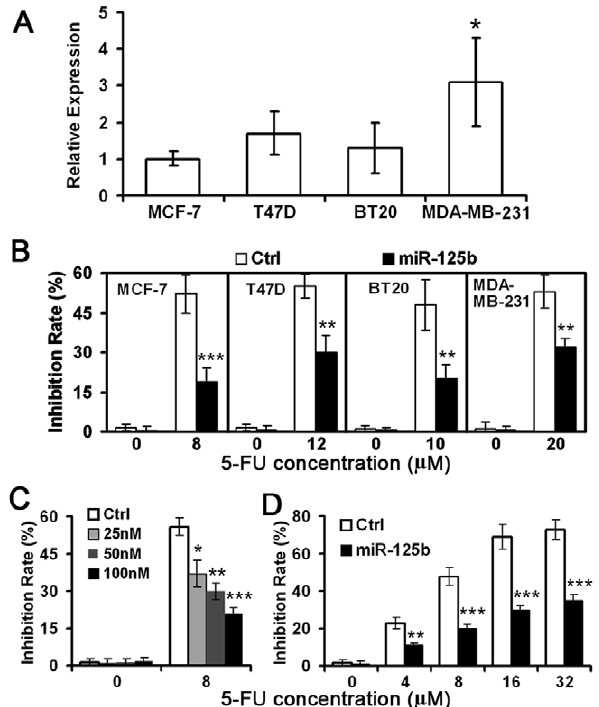
Figure 4. Involvement of miR-125b in chemotherapeutic resistance in breast cancer cells. (A) Relative expression levels of endogenous miR-125b were measured in breast cancer cell lines by quantitative RT-PCR. Data represented mean 6 SD. * p , 0.05 compared to MCF-7. (B) Breast cancer cells, MCF-7, T47D, BT20 and MDA-MB-231, were transfected with 100 nM pre-miR-125b and treated with the indicated concentrations of 5-FU for 48 h. A scramble pre-miRNA sequence served as a negative control (Ctrl). MCF-7 cells were transfected with 0, 25, 50, and 100 nM pre-miR-125b and then incubated with 8 m M 5-FU (C) or were treated with 0, 4, 8, 16, and 32 m M 5-FU for 48 h after transfection of 100 nM miRNA mimics (D). Cell variability was determined by trypan blue dye exclusion assays. Data represented mean 6 SD of triplicate experiments. * p , 0.05, ** p , 0.01, *** p , 0.001 compared to Ctrl.